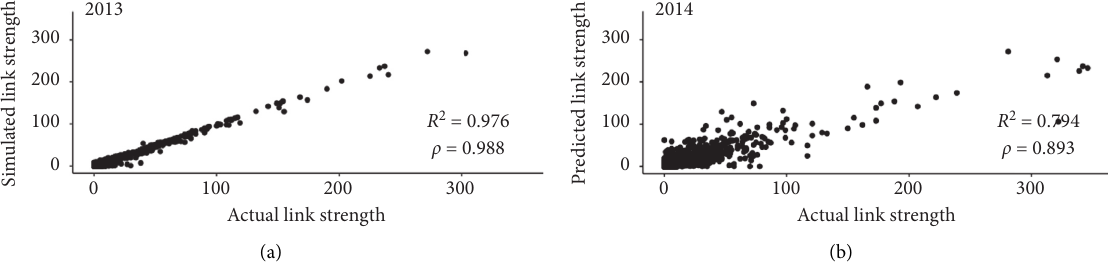
Figure 4: The goodness of fit using link strength comparison between the trained network and simulated network: (a) link strengths of the trained network with the aggregated simulated network for 2013 and (b) link strengths of the true network with the aggregated simulated network for 2014 (unseen future data).